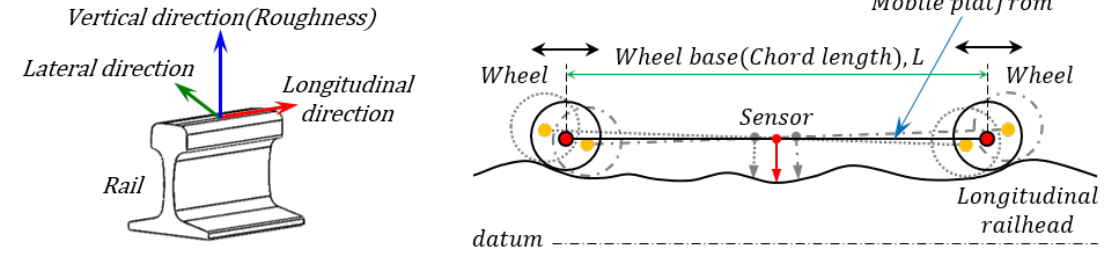
Figure 3. Mobile platform to measure longitudinal railhead